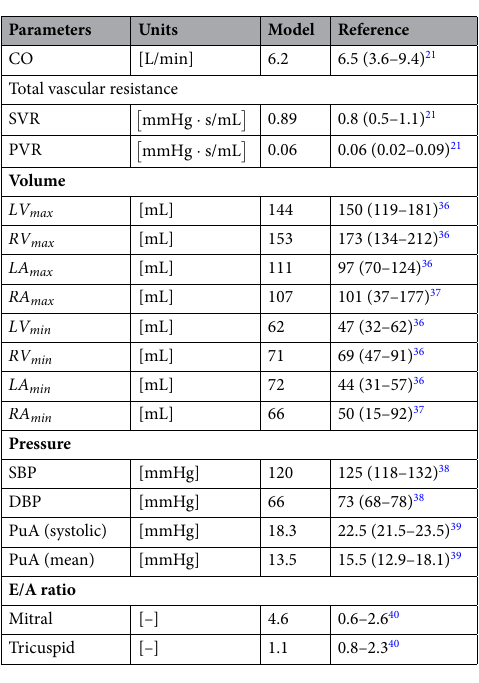
Table 1. Comparison of the healthy condition outputs with in vivo reference data given as a mean with range.